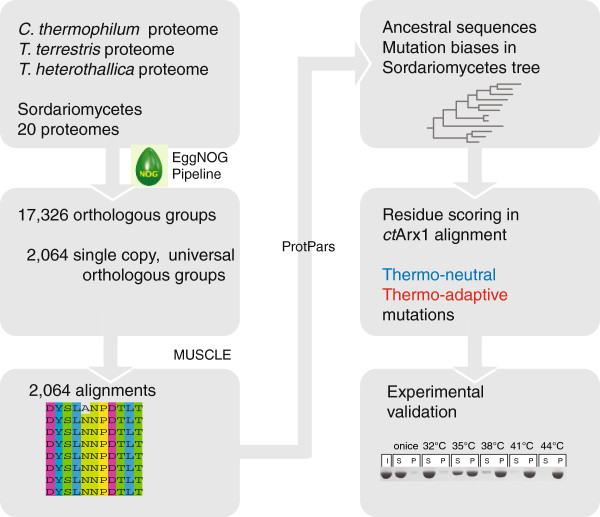
Workflow for finding biases and a scoring scheme of thermophilic mutations.